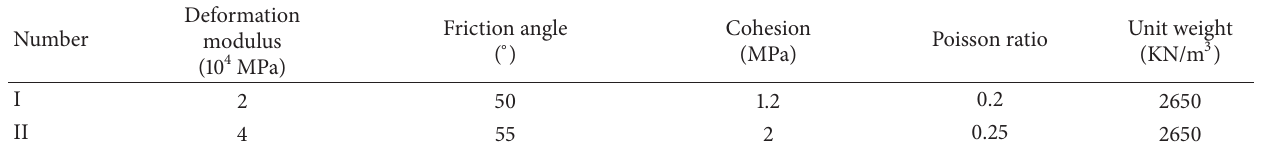
Table 3: Mechanical parameters of surrounding rock.